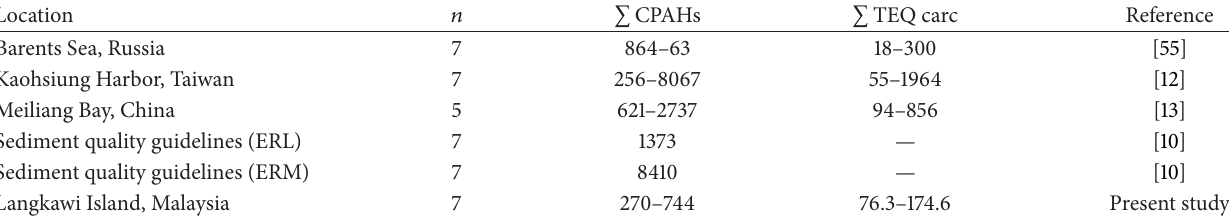
Table 8: Concentration of carcinogenic PAHs (ngg − 1 dry wt.) and total toxic BaP equivalent (total TEQ, ngTEQ g − 1 dry wt.) in sediments from different locations around the world; data show range.